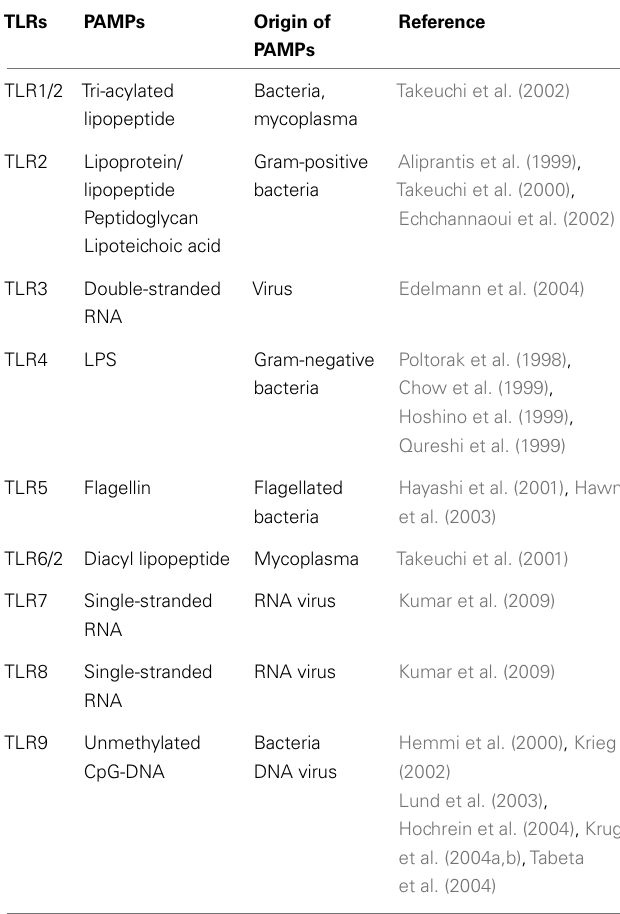
Table 1 | PAMPs recognized by the toll-like receptors